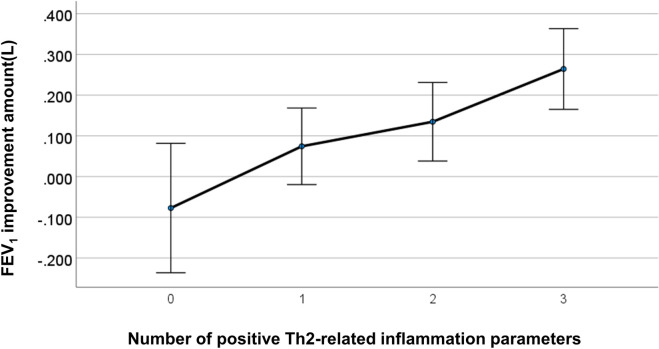
Correlation between FEV1 improvement and the number of increased type 2-related inflammation parameters.An increased level of each type 2-related markers was counted as 1, resulting in a sum ranging from 0 (none of type-2 parameters were elevated) to 3 (all 3 type 2 markers were elevated) for each patient. Error bars: +/- 2SE.